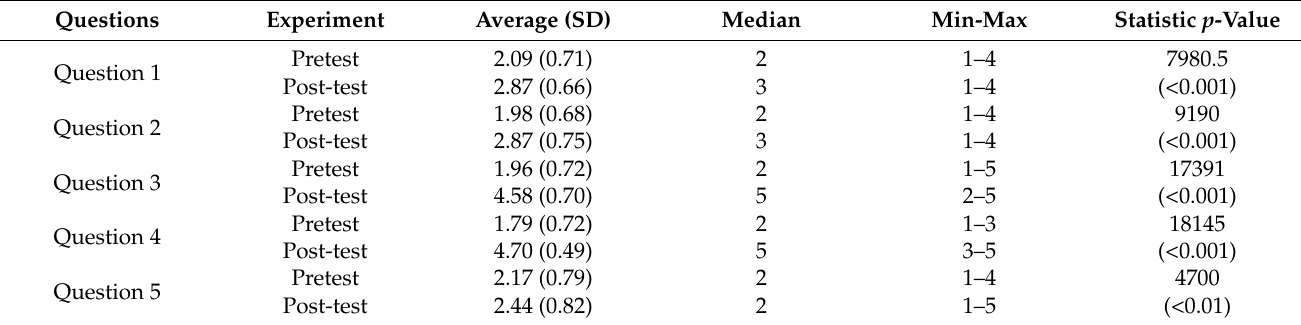
Table 3. Wilcoxon signed rank result.